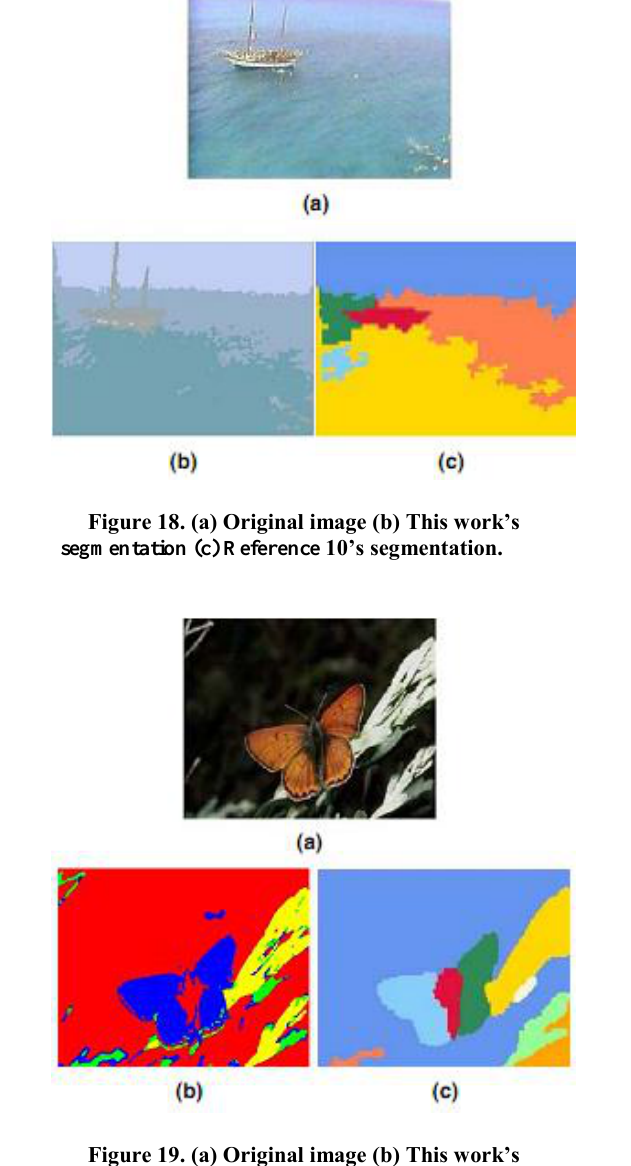
Figure 19. (a) Original image (b) This work’s segmentation (c) Reference 10’s segmentation.